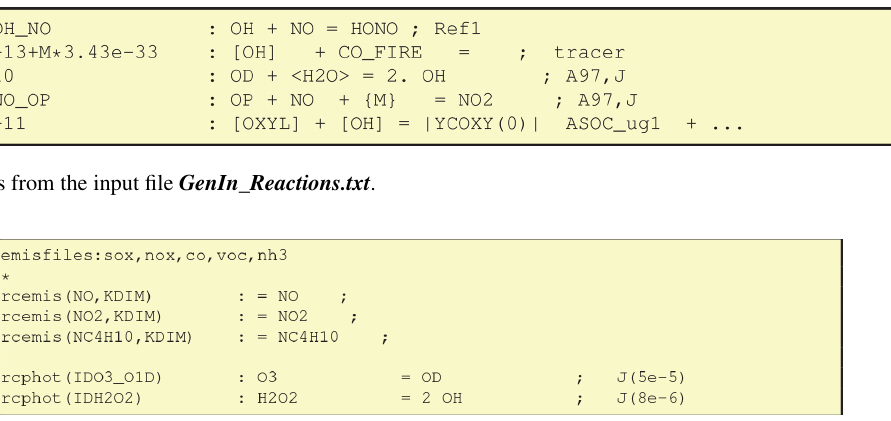
Figure 6. Emissions and photolysis lines from the input file GenIn_Reactions.txt